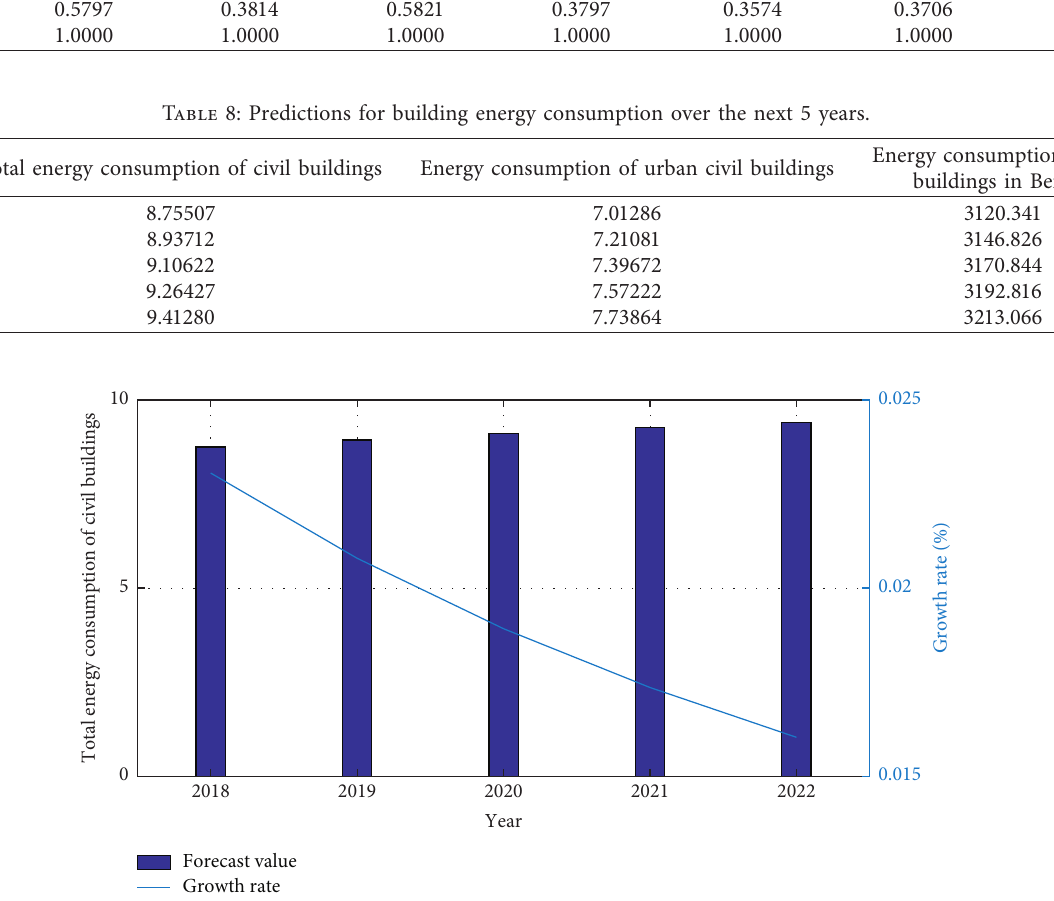
Figure 14: Total energy consumption of civil buildings and growth rate over the next 5